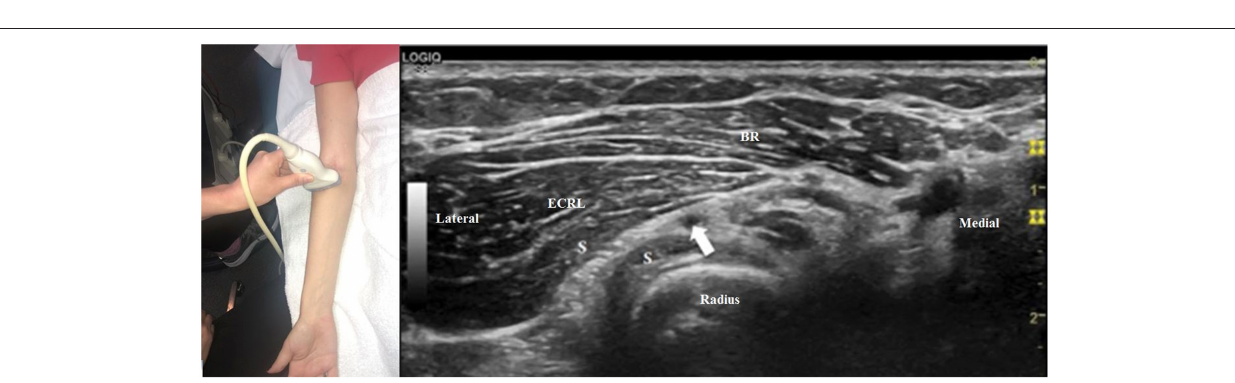
Frontiers in Neurology |